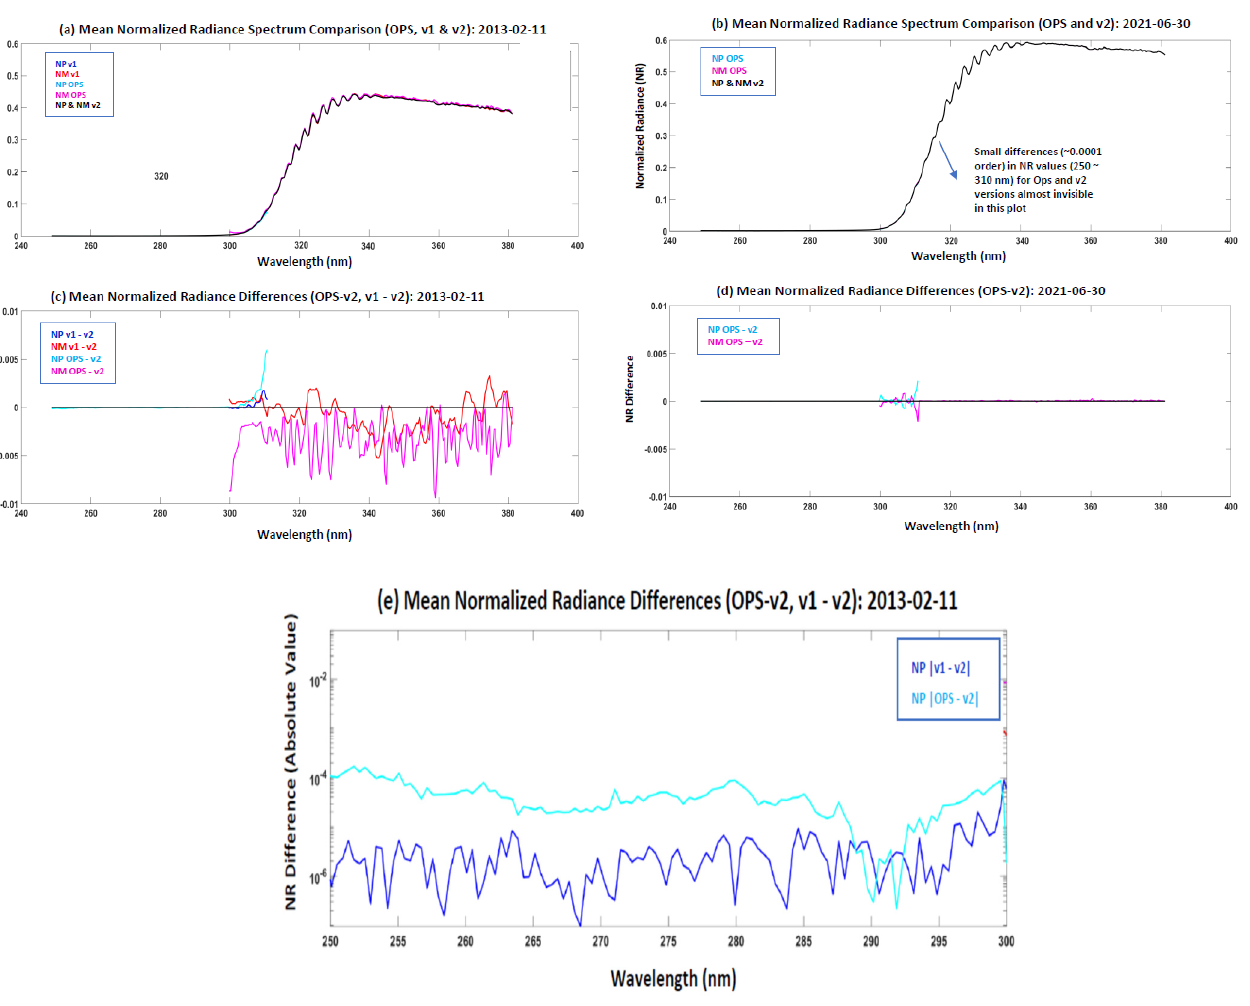
Figure 14. Comparison of the averaged normalized radiance spectra from 250 nm through 380 nm using the three data sets over a small box (10° × 10°) along San Francisco International airport and the spectrum difference against the 𝑣 2 data set, at two dates. ( a ) Averaged normalized radiance spectra using the three data sets (OPS, 𝑣 1 , and 𝑣 2 ) on 11 February 2013. ( b ) Same as ( a ) except for 30 June 2021. ( c ) Averaged normalized radiance difference 11 February 2013. ( d ) Same as ( c ) except for 30 June 2021. ( e ) Same as ( c ) except for a shorter wavelength range from 250 to 300 nm and in a log scale for y -axis.